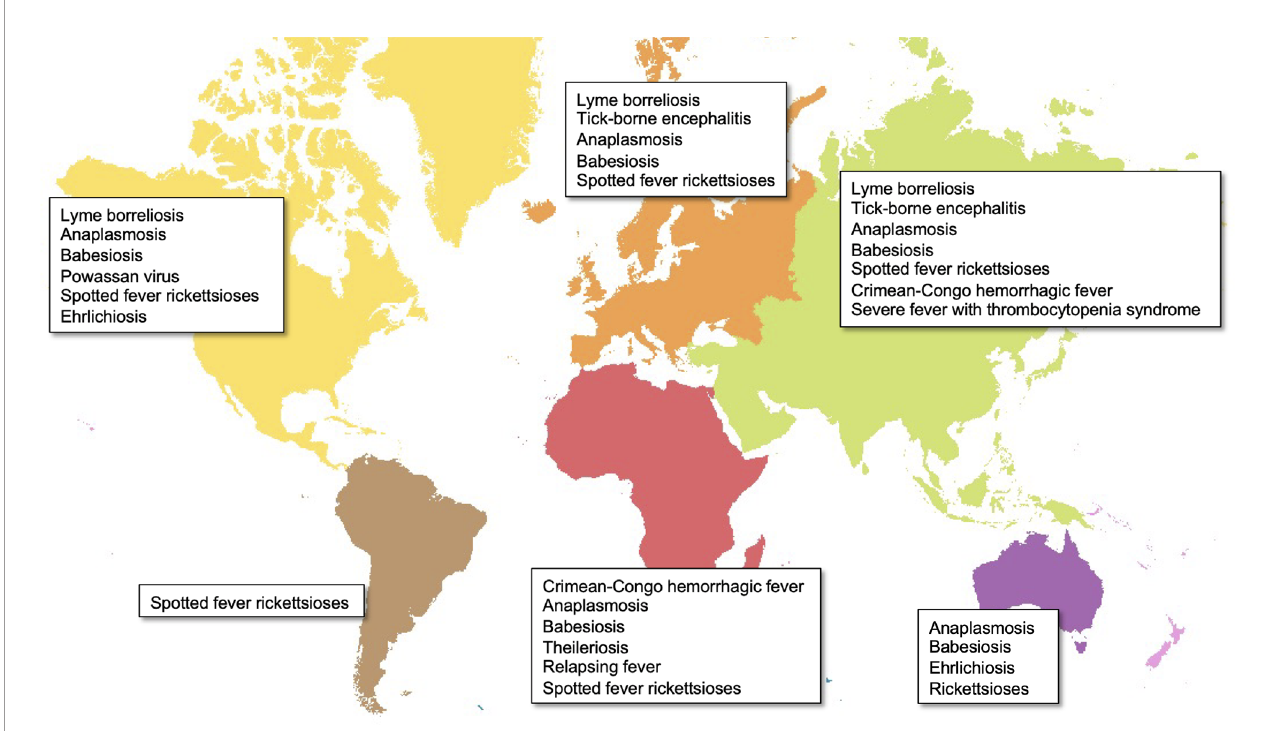
FIGURE 1 | Global distribution of major tick-borne diseases by continent. Map created in ArcGIS online (ESRI, California) using open-source layers from Natural Earth